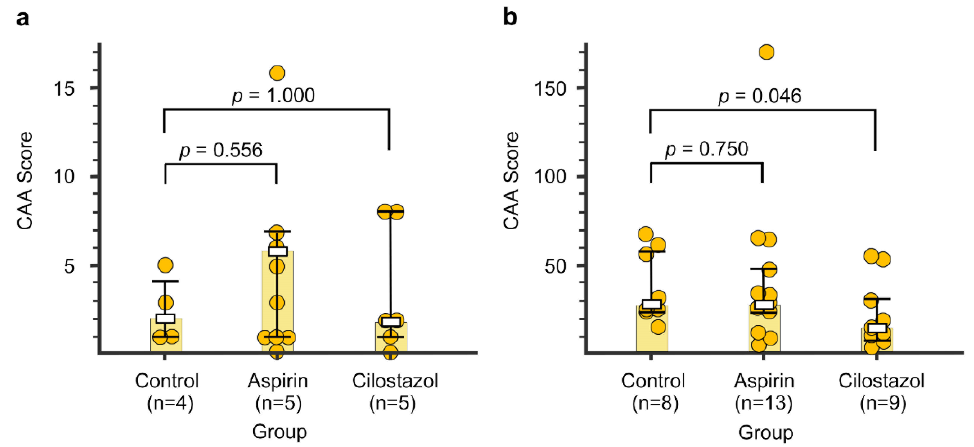
Figure 6. The cerebral amyloid angiopathy (CAA) scores in the control, aspirin, and cilostazol groups evaluated at 15 months ( a ) and 21–23 months ( b ). Light-yellow-colored bar graphs indicate median. Boxes and bars indicate median and interquartile range, respectively. Yellow circles represent the CAA score of each